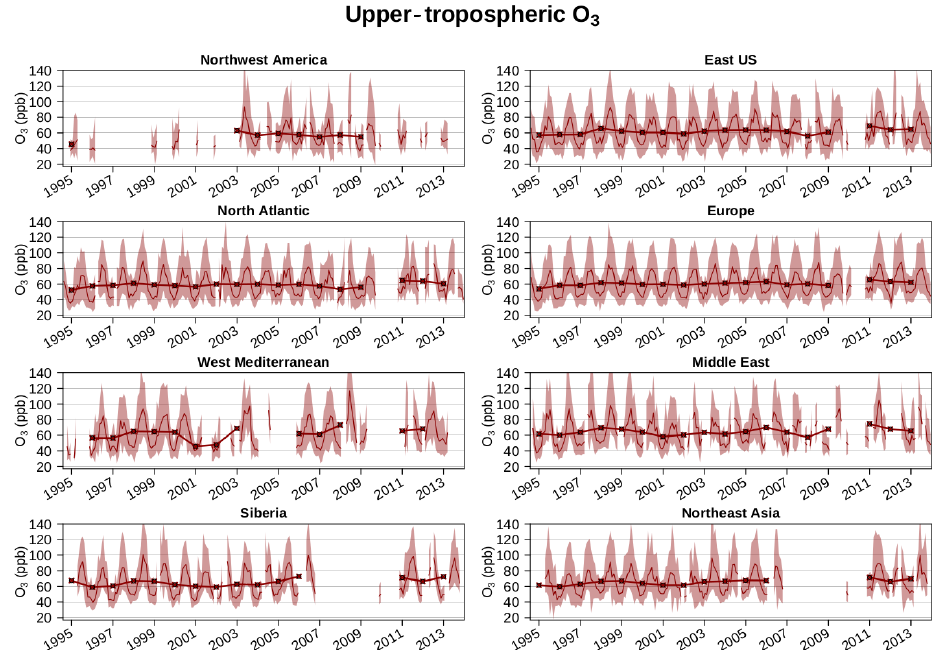
Figure B1. O 3 monthly mean values in the UT (thin curve). The interval from 5th and 95th percentiles is filled in red. The yearly mean values are represented by the bold curve and the black points.